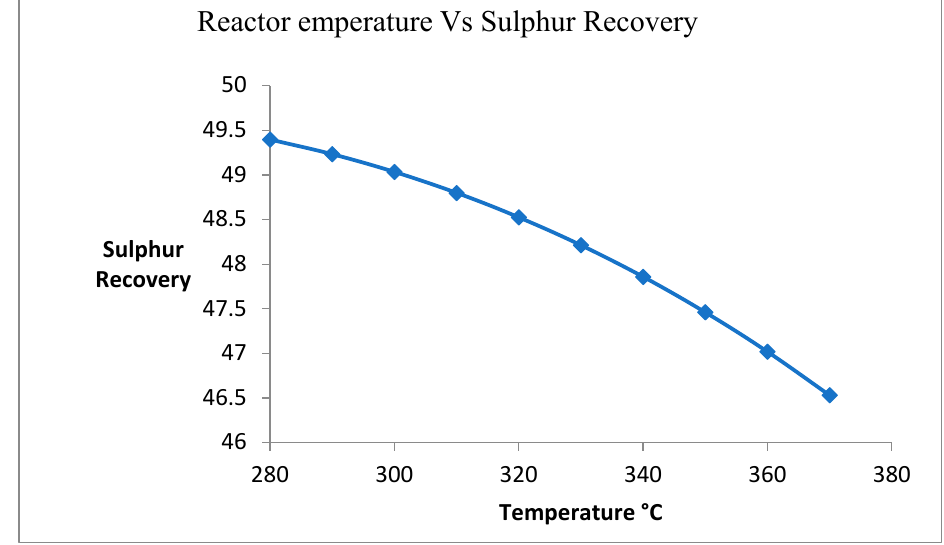
Figure 5. Effect of change in temperature on sulfur recovery.